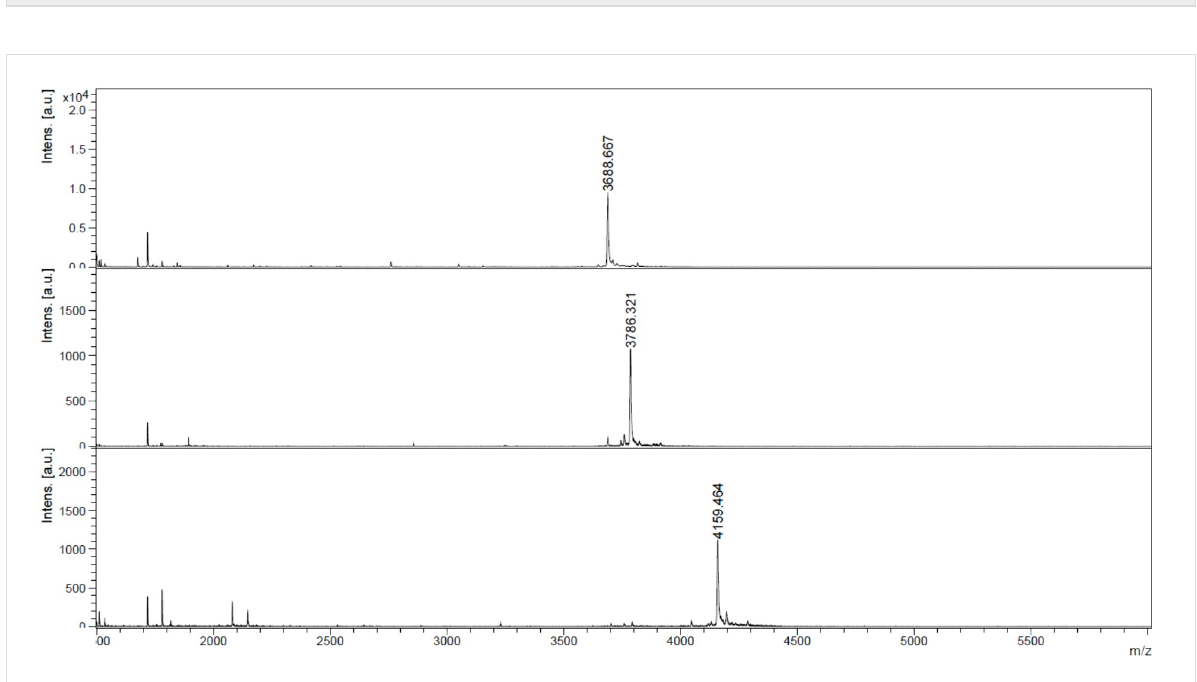
Figure 1: MALDI–TOF mass spectra of the crude 10mer acpcPNA before (top) (calcd m / z 3688.0), and after functionalizing with the azidobutyl group (middle) (calcd m / z 3785.1), and followed by clicking with Nile red (bottom) (calcd m / z 4157.5).